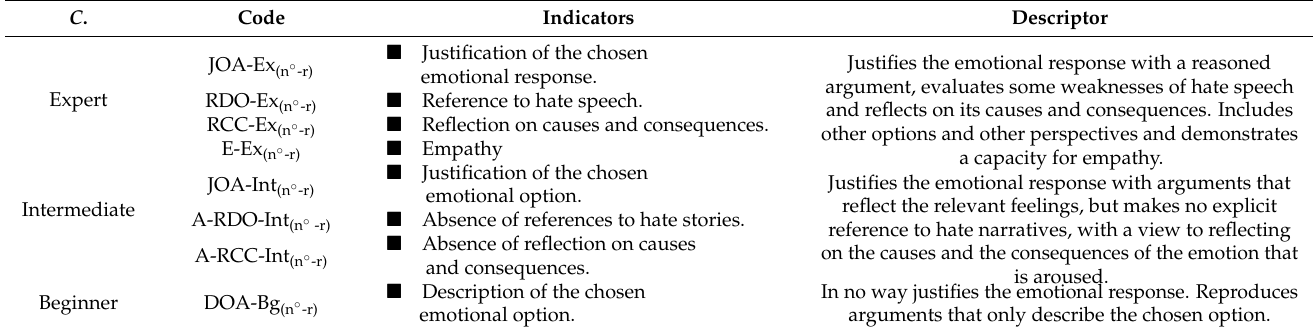
Table 2. System of categories.